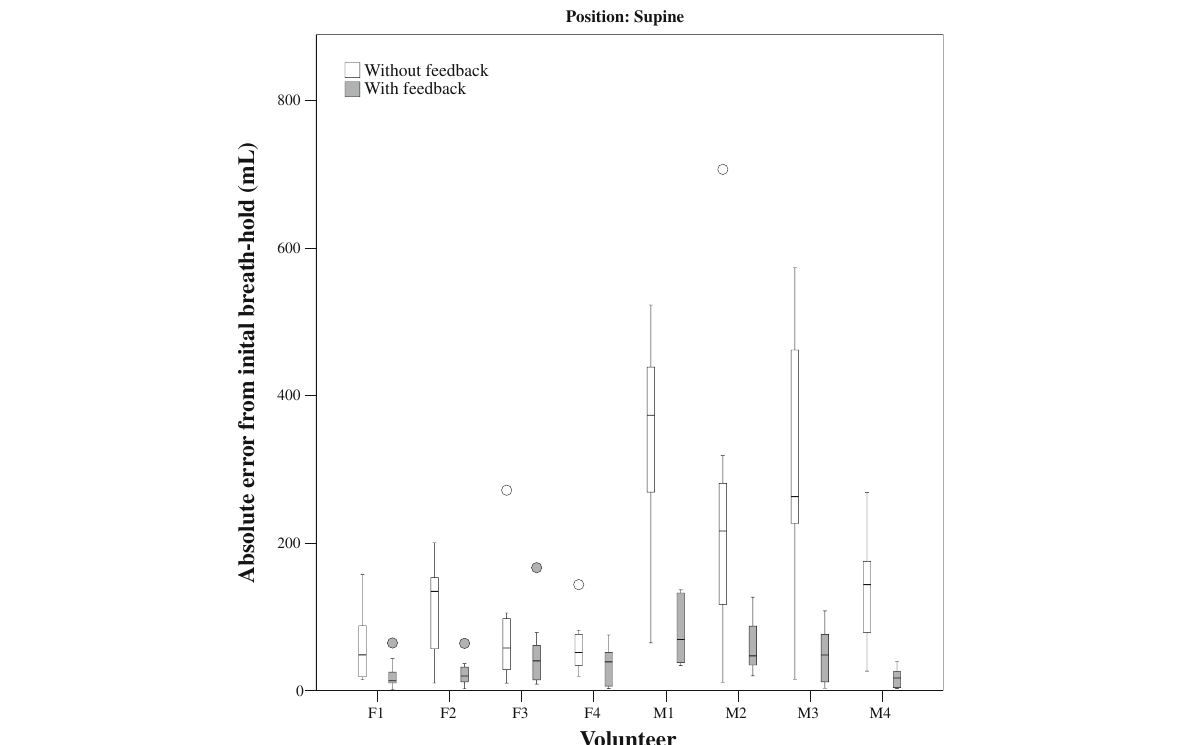
Table 1 Absolute error from initial breath-hold at expiration